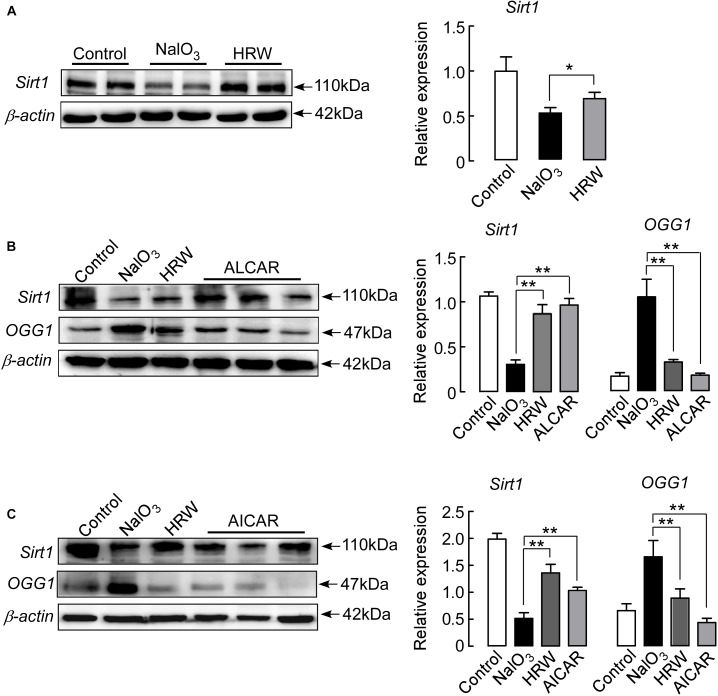
HRW upregulates Sirt1 expression in the retina by inhibiting oxidative stress. (A) Representative blots and quantitative analysis of Sirt1 protein expression at 5 days after NaIO3 injection. Mice were pretreated with ALCAR (0.2 mg/g, i.p.) (B) or AICAR (0.5 mg/g, i.p.) (C) before NaIO3 injection. The expression of Sirt1 and OGG1 were measured by Western blotting. Data represent the mean ± SEM of three independent experiments, n = 3–6, ∗P < 0.05, ∗∗P < 0.01 vs. the NaIO3 group.